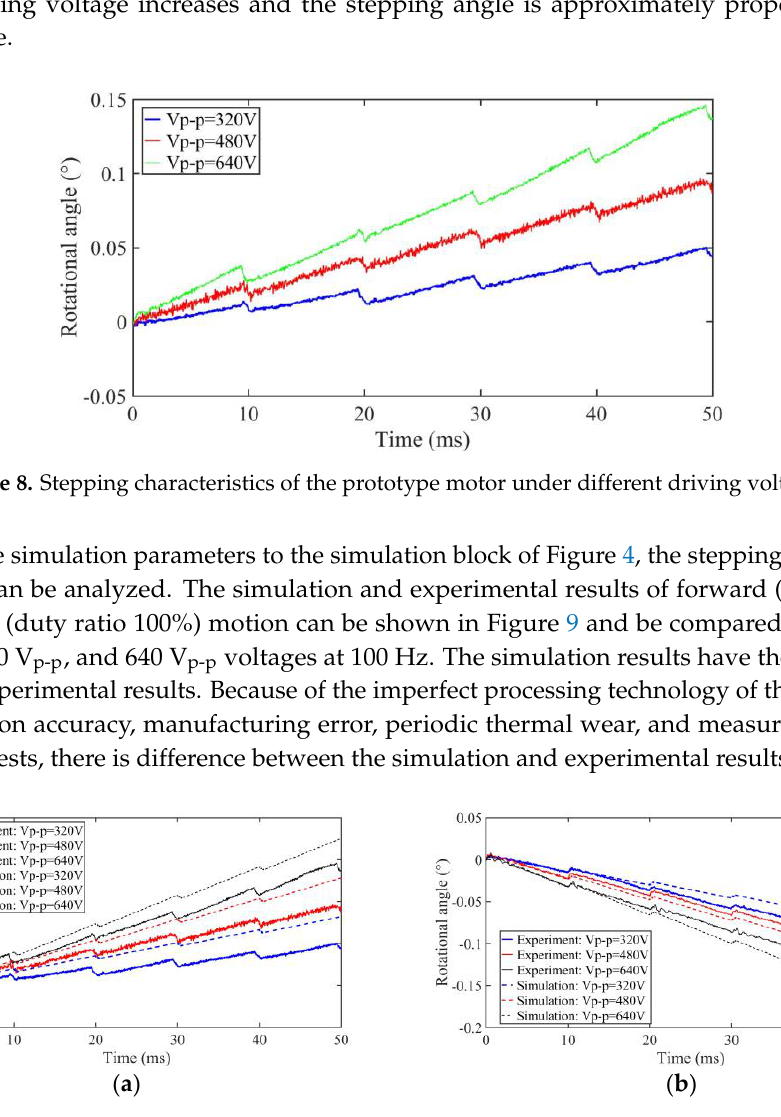
Figure 9. Stepping characteristics of the prototype motor under different driving voltages in experiments and simulations: ( a ) forward; ( b ) backward.